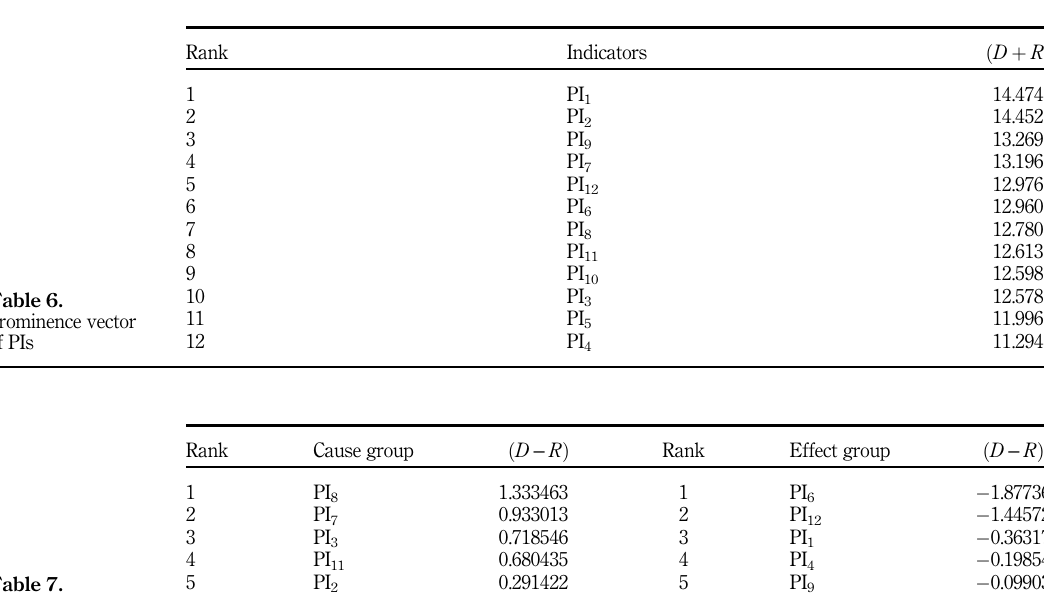
Table 7. Relation vector of